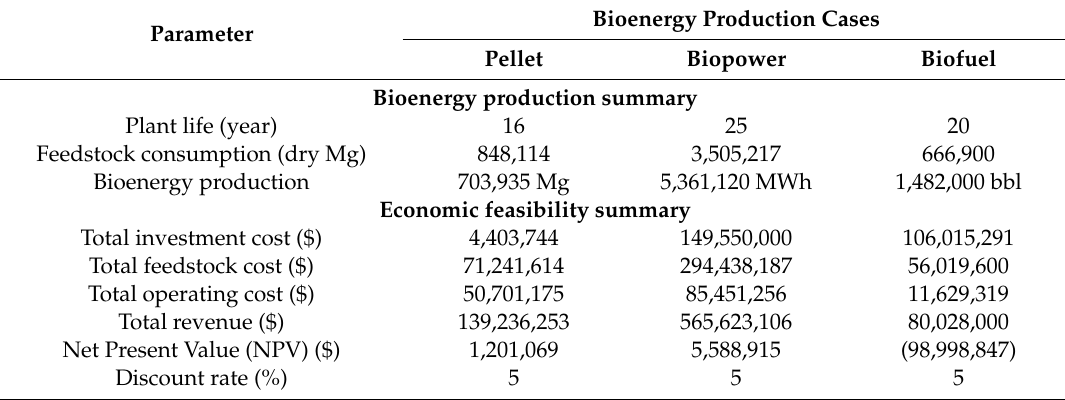
Table 4. Economic evaluation for three bioenergy production cases: pellet, biopower, and